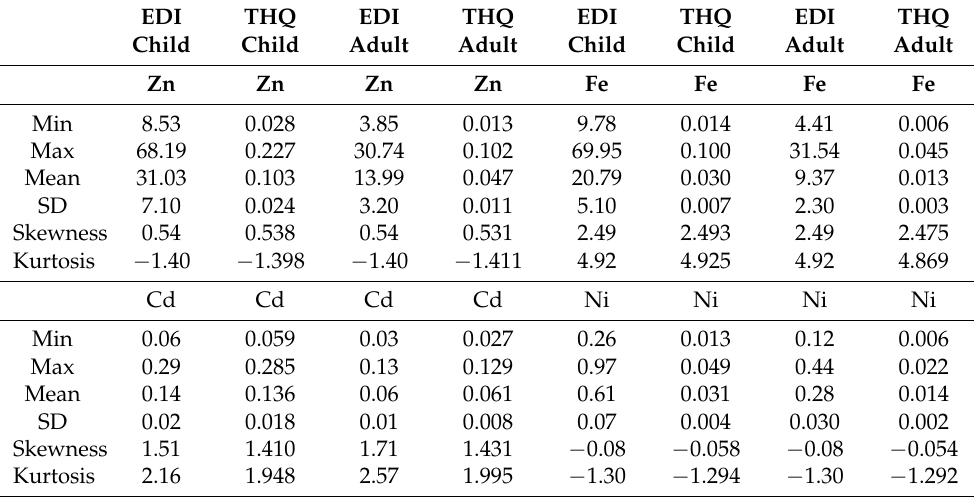
Table 5. Overall values of estimated daily intake (EDI, µ g/kg wet weight/day), and the target hazard quotient (THQ, unitless) values of Cd, Fe, Ni, and Zn on the edible leaves of Amaranthus viridis (based on 11 sampling